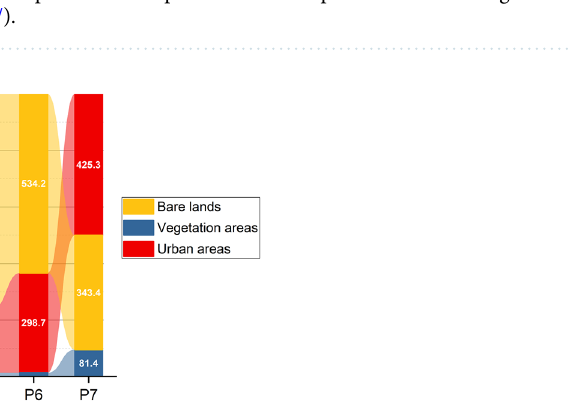
Figure 3. Changes between the three land-use classes in Doha during the seven studied periods. Labels show the area of each category in km 2